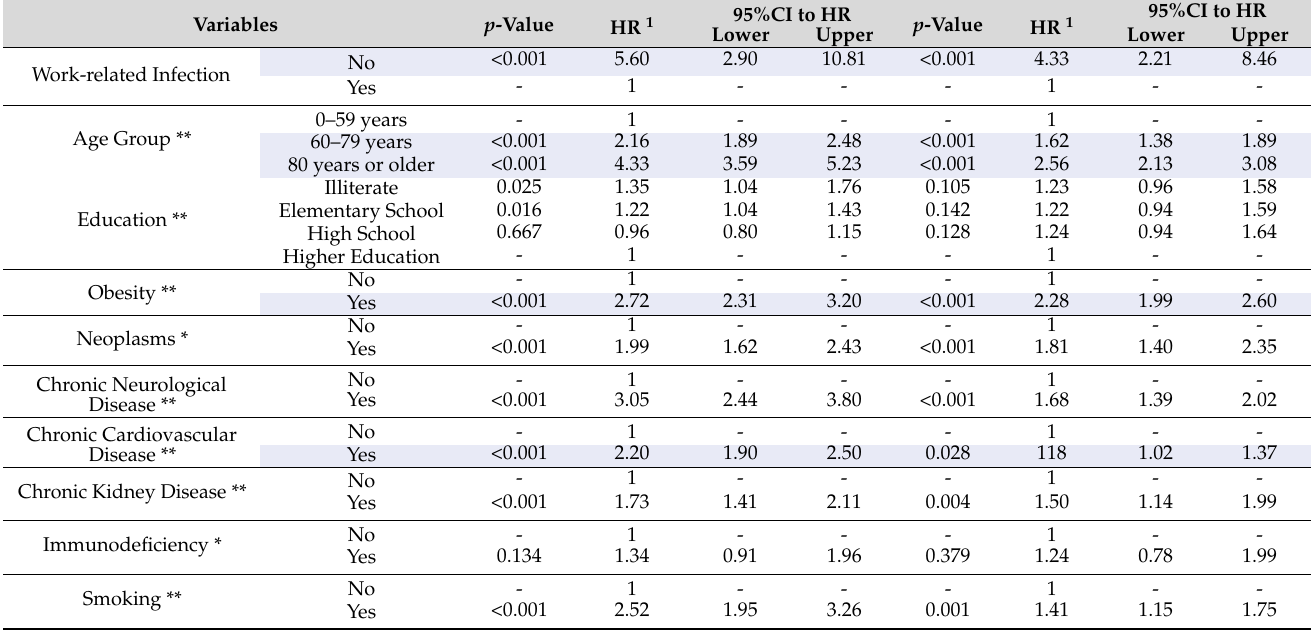
Table 5. Multivariable survival (crude and adjusted Hazard Ratio by Cox regression model) for the outcome of death from COVID-19 in hospitalized patients in the state of Esp í rito Santo, Brazil,